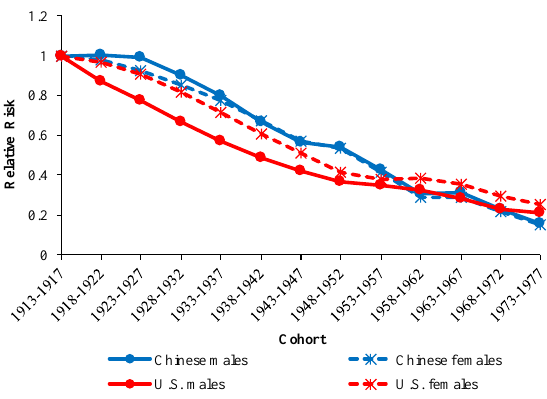
Figure 7. Cohort effects on COPD mortality by sex in China and the U.S. Figure 7. Cohort e ff ects on COPD mortality by sex in China and the